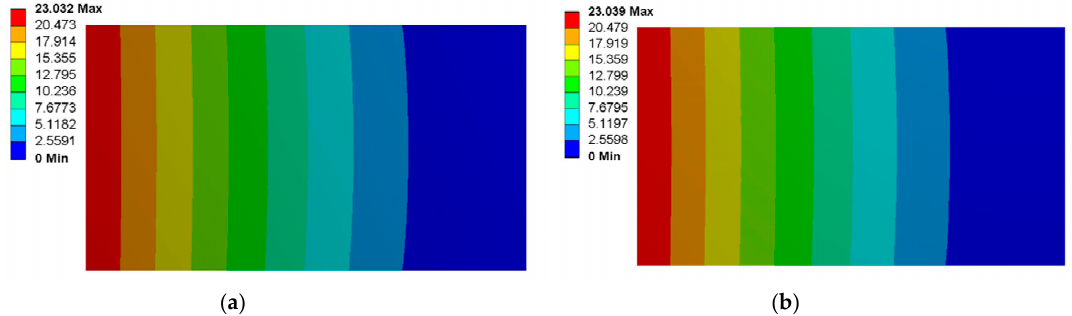
Figure 11. Natural frequency from simulation (unit: m); ( a ) without piezo properties = 75.4 Hz; ( b ) with piezo properties = 76.9 Hz.